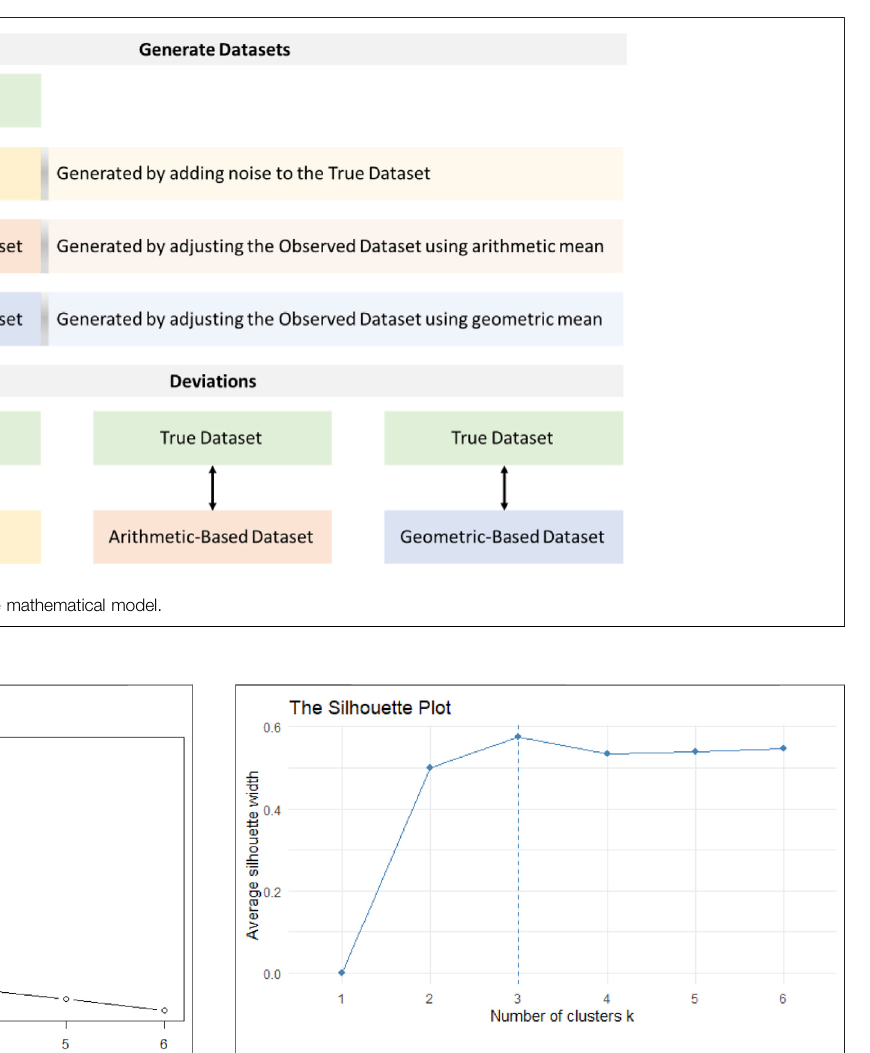
FIGURE 7 | Silhouette plot for the k-means cluster analysis of the 43 AR